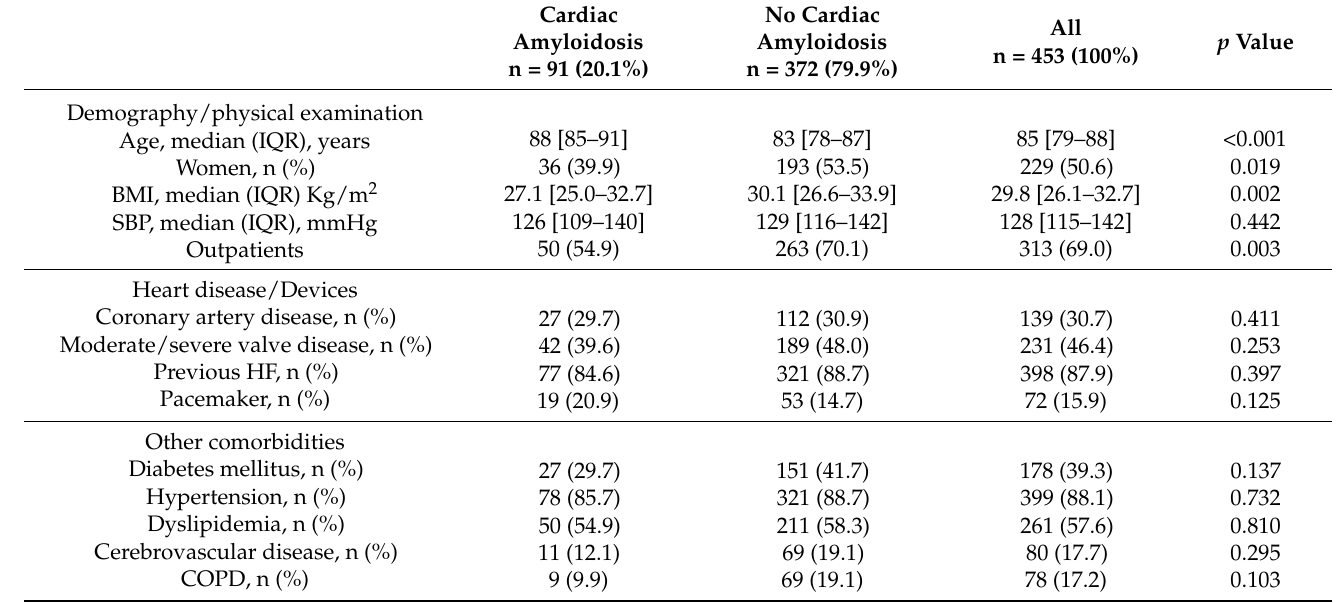
Table 1. Baseline characteristics of the population. Figure 2. Cardiac amyloidosis prevalence according to age and sex.